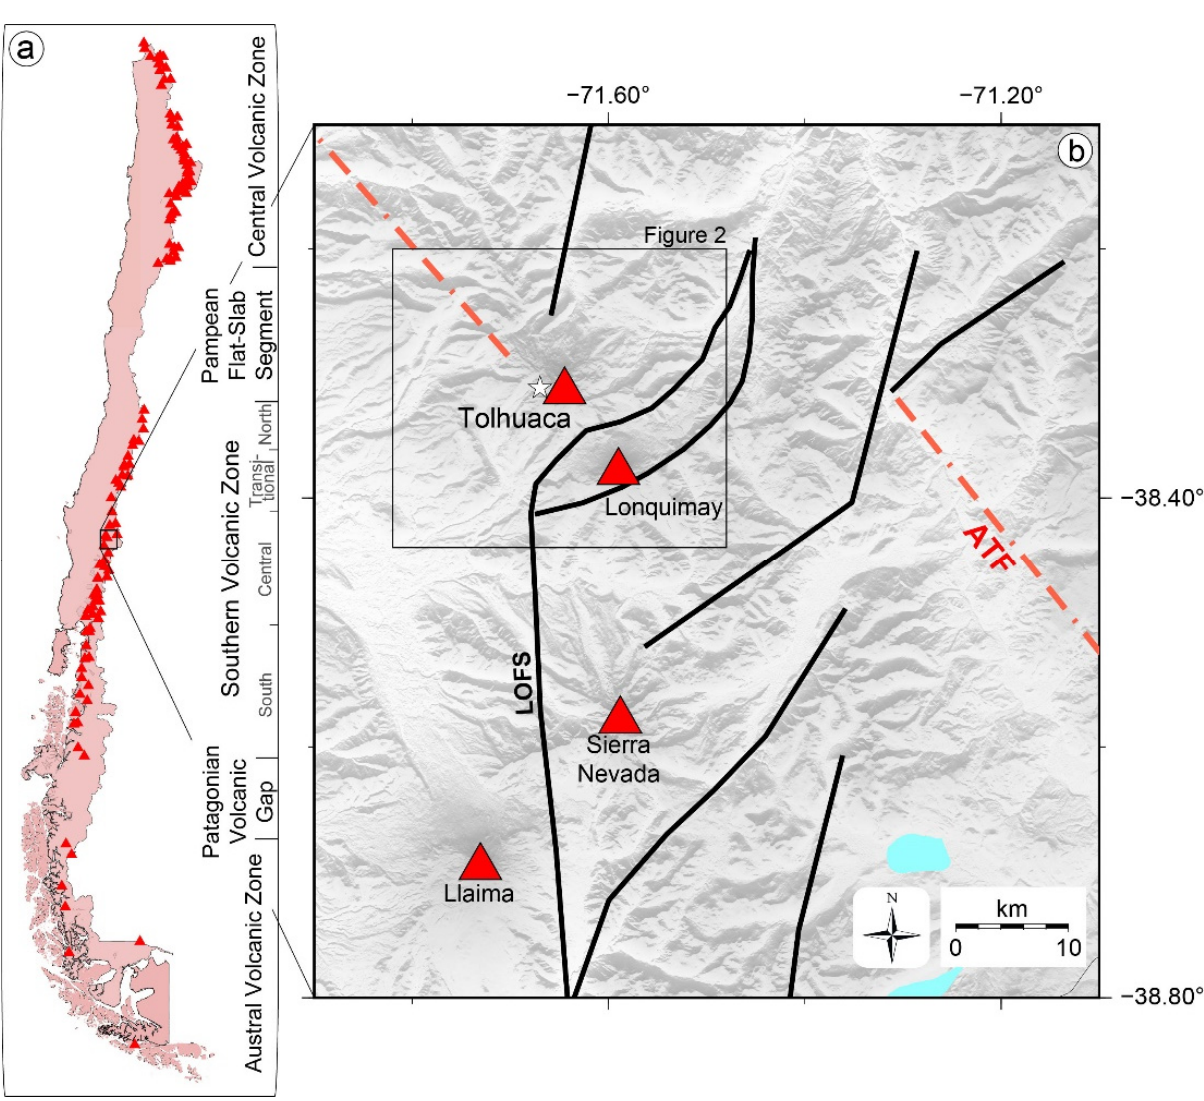
Figure 1. ( a ) Schematic map of the volcanic setting along the Chilean Andes showing the three main volcanic zones. All types of volcanic edifies are represented by red triangles (https://portalgeominbeta.sernageomin.cl (accessed on 28 November 2022)). ( b ) Simplified map of the major structural systems of the Liquiñe-Ofqui Fault system (LOFS) and the Andean Transversal Fault (ATF). Red triangles represent Holocene stratovolcanoes. Llaima and Lonquimay are counted among the most active volcanoes in Chile, while Tolhuaca is dormant and Sierra Nevada is extinct [7]. The white star indicates the location of the Tolhuaca Geothermal System. More than 300 potential geothermal areas have been indicated throughout the Chilean Andes [8,9], associated with Quaternary volcanism. The main high-enthalpy geothermal systems occur in CVZ (e.g., Apacheta, El Tatio) and SVZ (e.g., Tinguiririca, Mariposa, Tolhuaca) [8]. In areas where Quaternary volcanism is absent, Pampean Flat-slab Segment and Patagonia Volcanic Gap, there are fewer hot springs or are less pronounced and their temperatures are usually lower